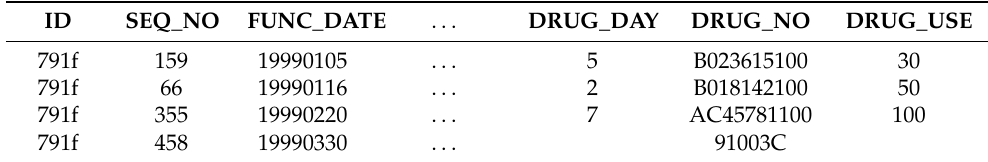
Table 4. 1999–2010 medical records of patients whose ID was